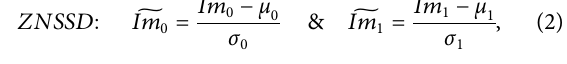
Frontiers in Physics |